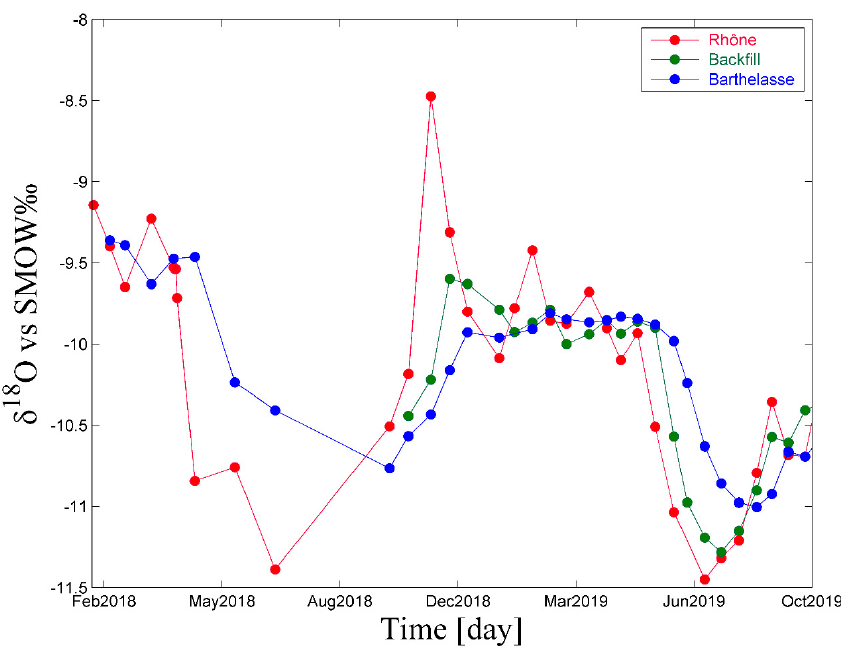
Figure 7. δ 18 O evolution in the Rhône, the backfill observation well and the Barthelasse observation well during the year 2018–2019.